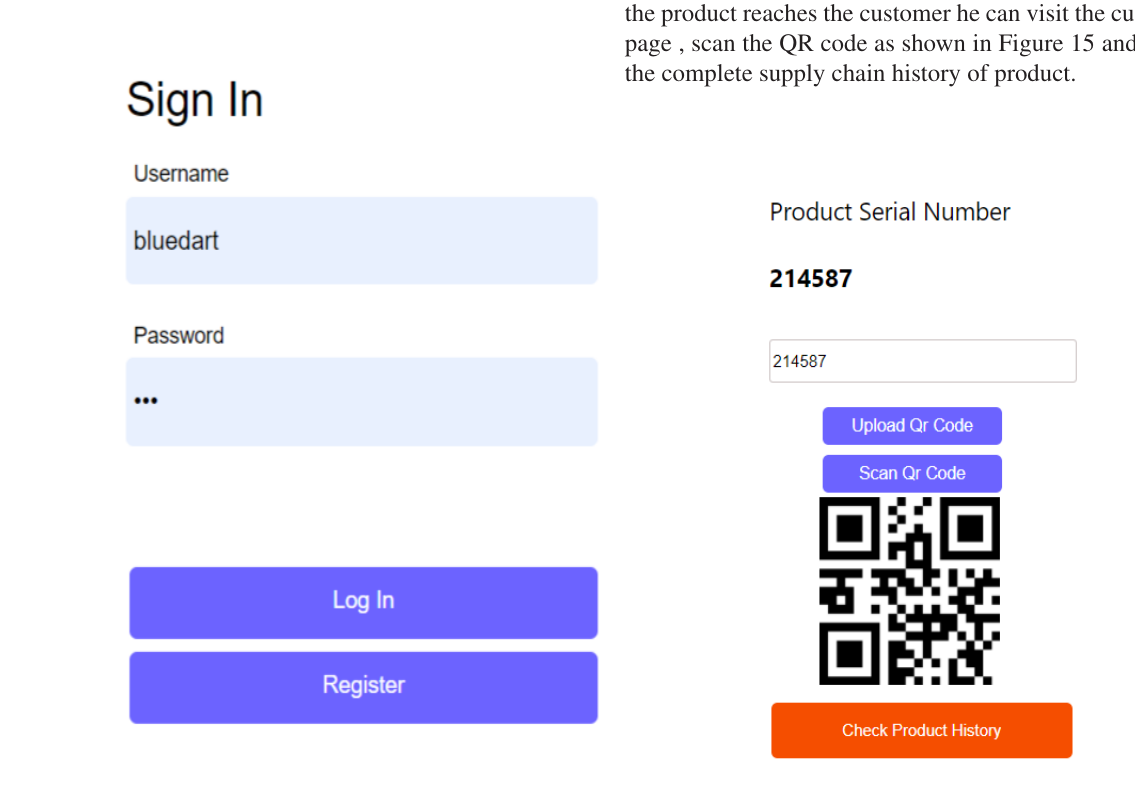
Figure 15: Customer page to check Supply chain